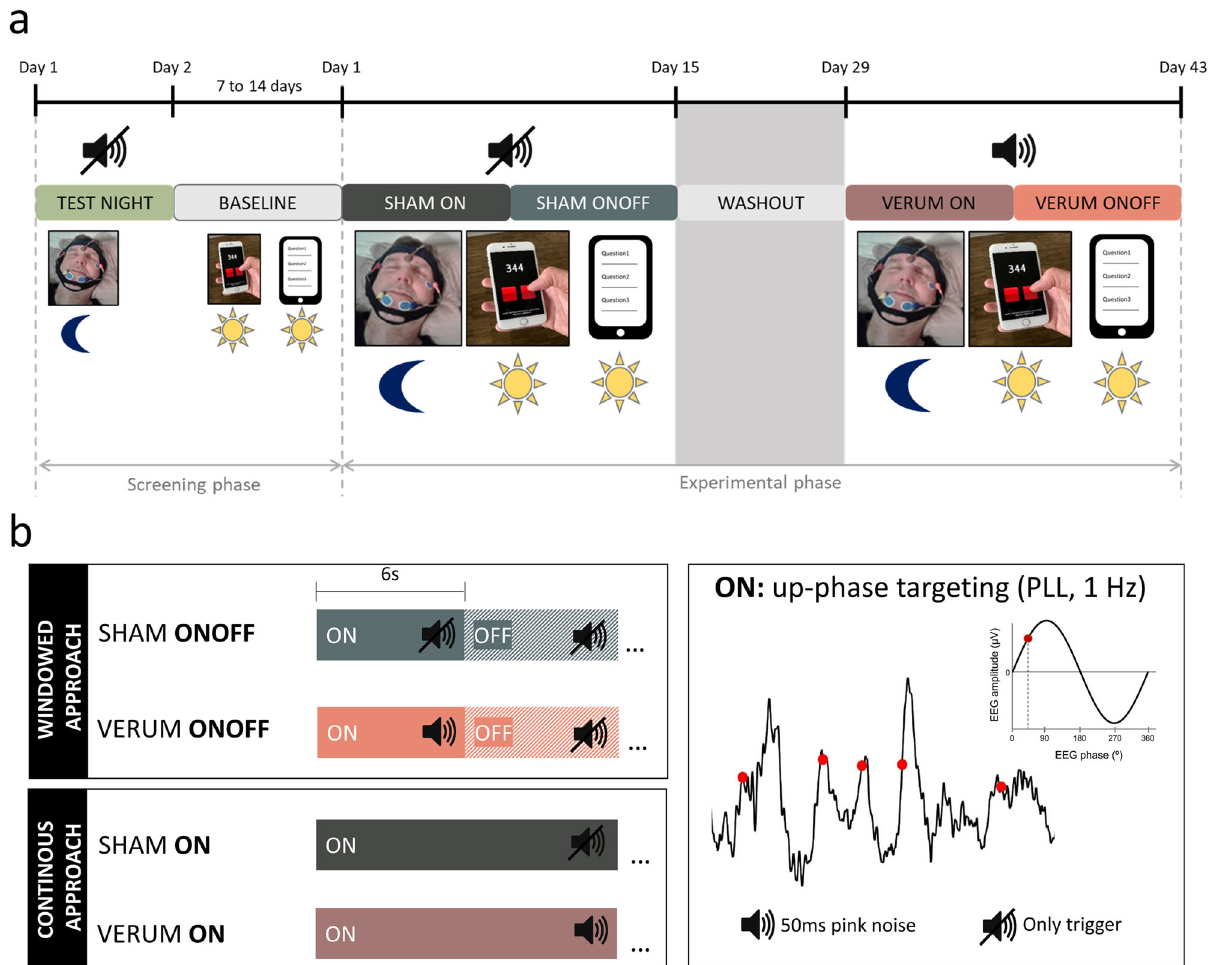
Fig. 1 Study and auditory stimulation design. a Participants fi rst underwent a screening phase to familiarize with the in-home MHSL-Sleepbandv2 (MHSL- SB) use and the mobile phone assessments. In the experimental phase, two-week intervention periods of either Sham (no auditory stimulation) or Verum (auditory stimulation) were conducted in a randomized, crossover design. Daytime recordings reported here (hallmarked by a sun) included subjective sleep quality assessment in the morning, a psychomotor vigilance test (PVT) at 2 pm, the Karolinska sleepiness scale (KSS) in the morning, at 2 pm, and 8 pm, and a mood assessment in the morning and at 8 pm. Nocturnal recordings (hallmarked by a moon) included the nightly application of the MHSL-SB that recorded Fpz-A2 (electroencephalography [EEG]), left and right electrooculography (EOG), and chin electromyography (EMG). The identi fi able person in this fi gure provided written consent to publish this image. b The MHSL-SB performed a sleep classi fi cation and de fi ned stable NREM sleep and used a phase-locked-loop (PLL) to precisely time the slow wave modulation during up-phase of the slow wave. During Sham, only triggers were saved to mark slow wave up-phases, during Verum 50 ms pink noise bursts were applied (illustrated as red dots). The de fi ned PLL target phase was around 45°. In each intervention period two types of application were used, the continuous and windowed approach. In the windowed approach, 6 s ON and 6 s OFF windows were alternated, during OFF no slow waves were targeted (but marked), during ON slow wave up-phases were targeted and either stimulated with pink noise bursts (Verum) or only marked (Sham). During the continuous approach, all targeted slow wave up-phases were either stimulated (Verum) or marked (Sham). Each of these approaches lasted for 7 days in a counter-balanced design resulting in four possible order combinations that were counter-balanced across participants: (1) Verum ON, Verum ONOFF, Sham ON, Sham ONOFF, ( n subjects = 4) (2) Sham ON, Sham ONOFF, Verum ON, Verum ONOFF, ( n subjects = 3) (3) Verum ONOFF, Verum ON, Sham ONOFF, Sham ON, ( n subjects = 5) (4) Sham ONOFF, Sham ON, Verum ONOFF, Verum ON ( n subjects =